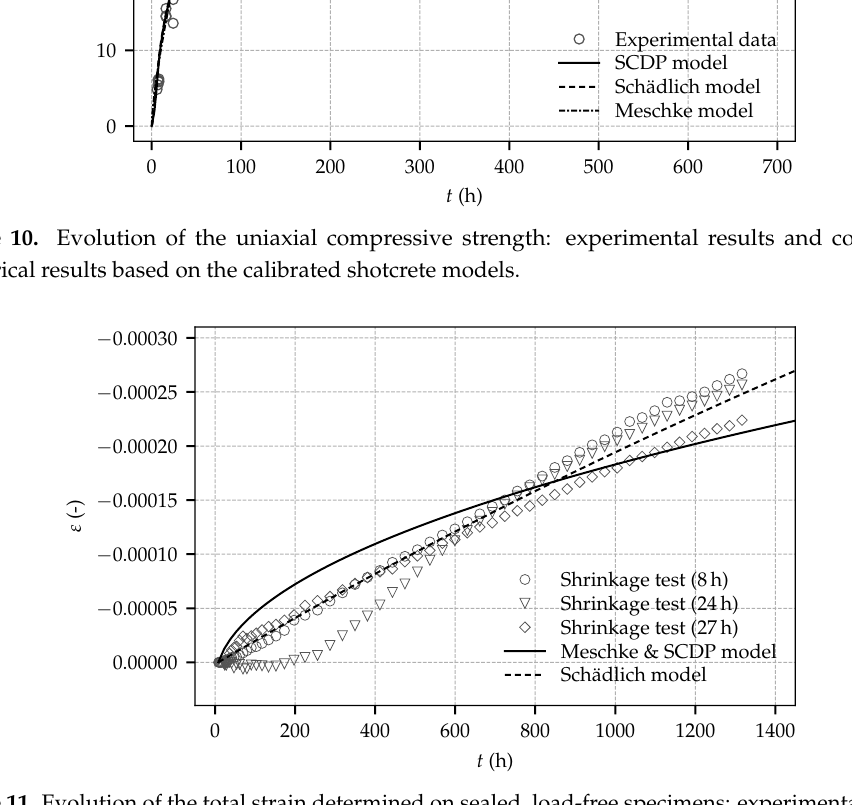
Figure 11. Evolution of the total strain determined on sealed, load-free specimens: experimental results and computed numerical results based on the calibrated shotcrete